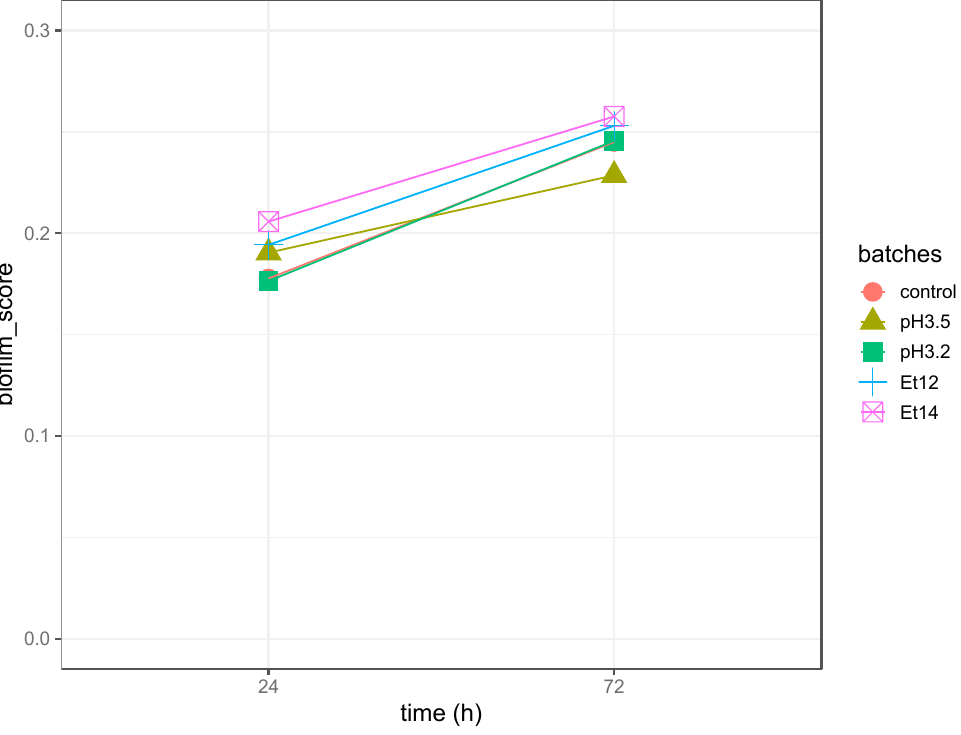
Figure 4. Biofilms produced (biofilm_score) by high producer strains of L. plantarum after 24 h and 72 h of incubation in MRS broth in presence of acid stress (pH 3.5 pH 3.2), ethanol stress (Et12, Et14) or without stress (control). The biofilm_score value is the ratio between the median values of crystal violet (CV) OD 620 (median values of OD 620 calculated on cells in biofilm form) and OD 620 (median values of OD 620 calculated on cells in planktonic form).